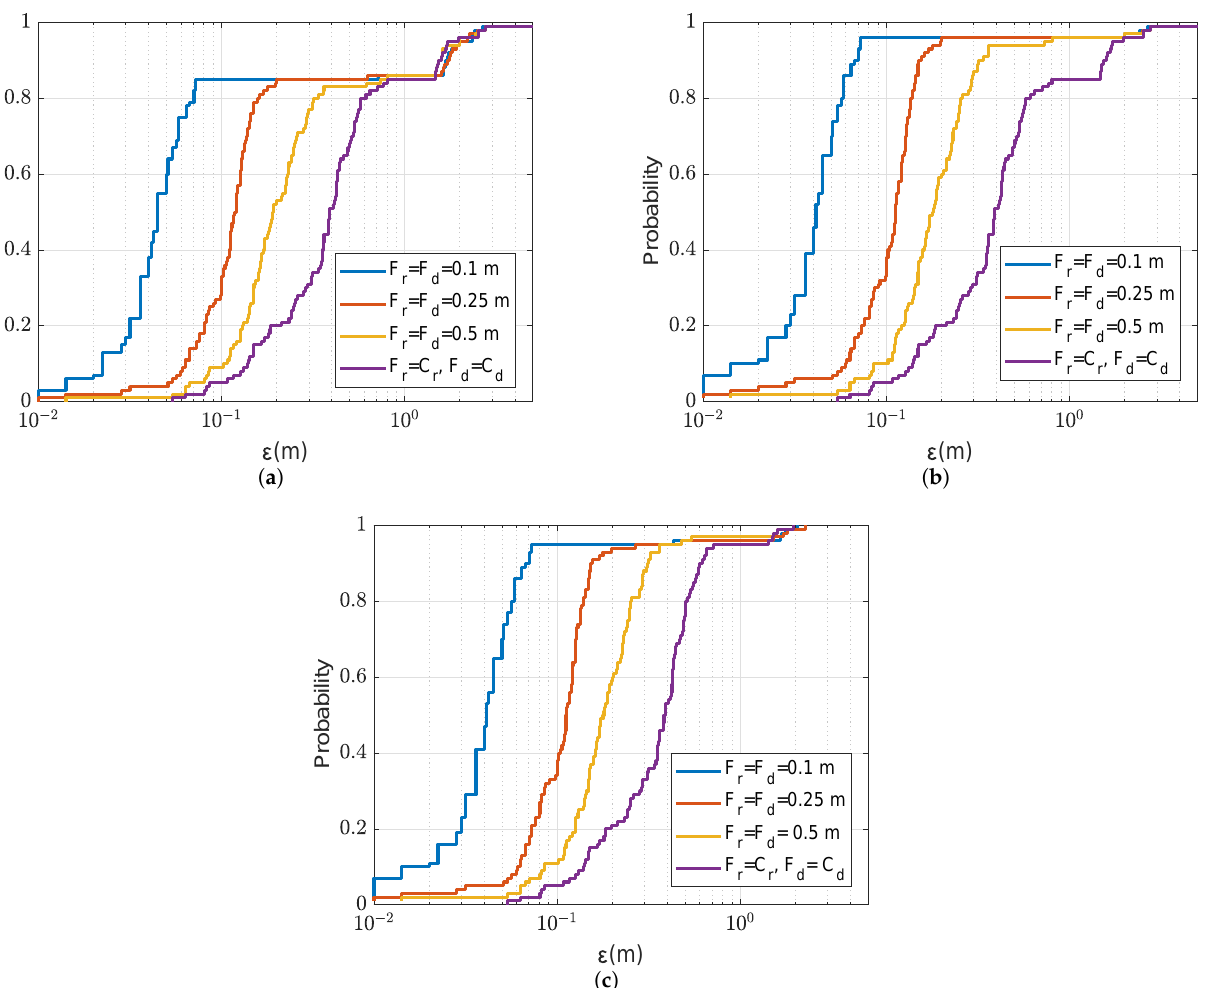
Figure 10. CDF of the localization error ε for the coarse-to-fine localization using the non-coherent AF against different refined steps in range F r and depth F d with two refinement areas of different size as shown in Figure 5; the SSP is uniform as shown in Figure 3. ( a ) N T = 1, refinement area: 2 m × 2